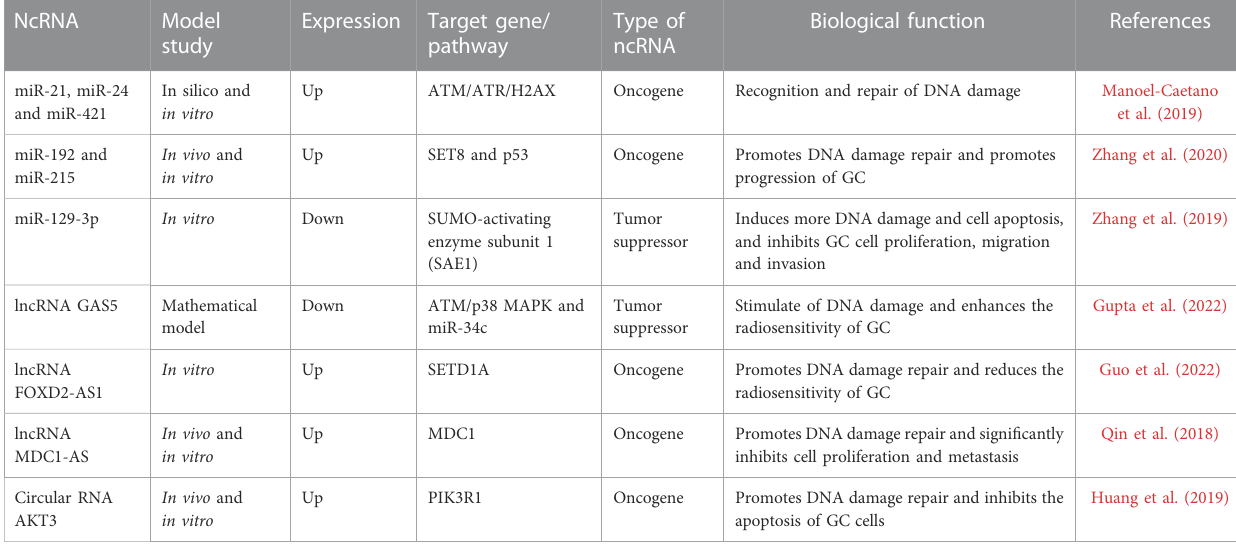
TABLE 1 Some non-coding RNAs (ncRNAs) that regulate DNA damage in gastric cancer (GC) cells under the in fl uence of